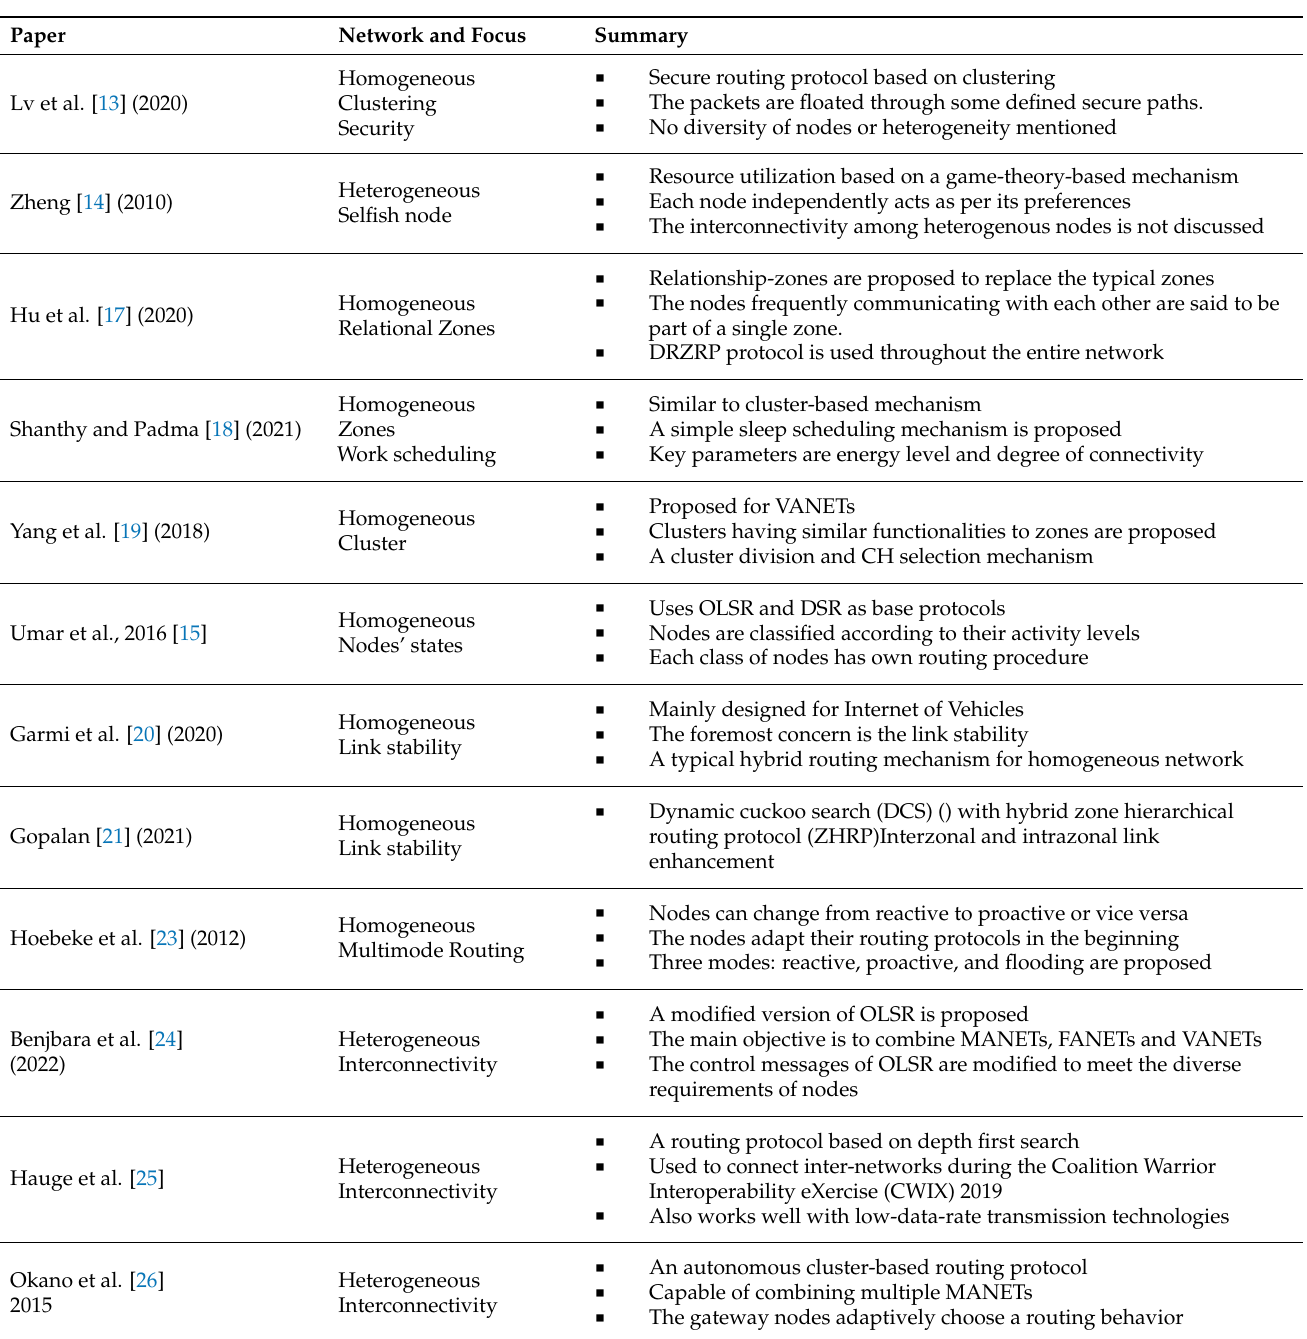
Table 1. Research papers focusing on game-theory-based routing .